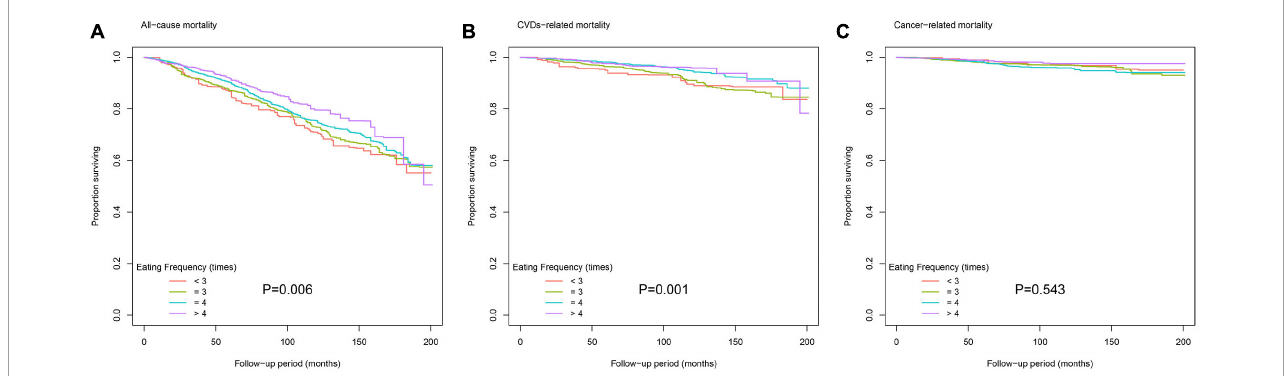
FIGURE1 Kaplan–Meier survival curve for (A) all-cause mortality, (B) cardiovascular disease (CVD)-related mortality, and (C) cancer-related mortality according to eating frequency.